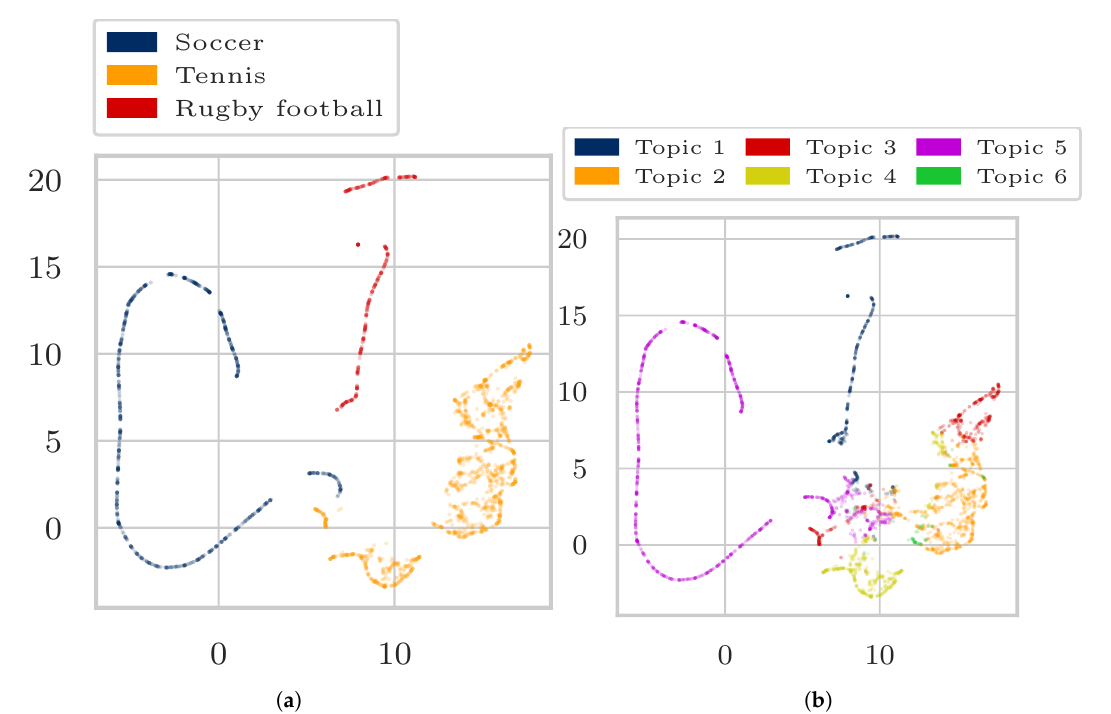
Figure A8. ( a ) 2-dimensional representation of word embeddings A colored by topic assignment. ( b ) 2-dimensional representation of word embeddings A colored by original Wikipedia article assignment (words that occur in more than one article are excluded).